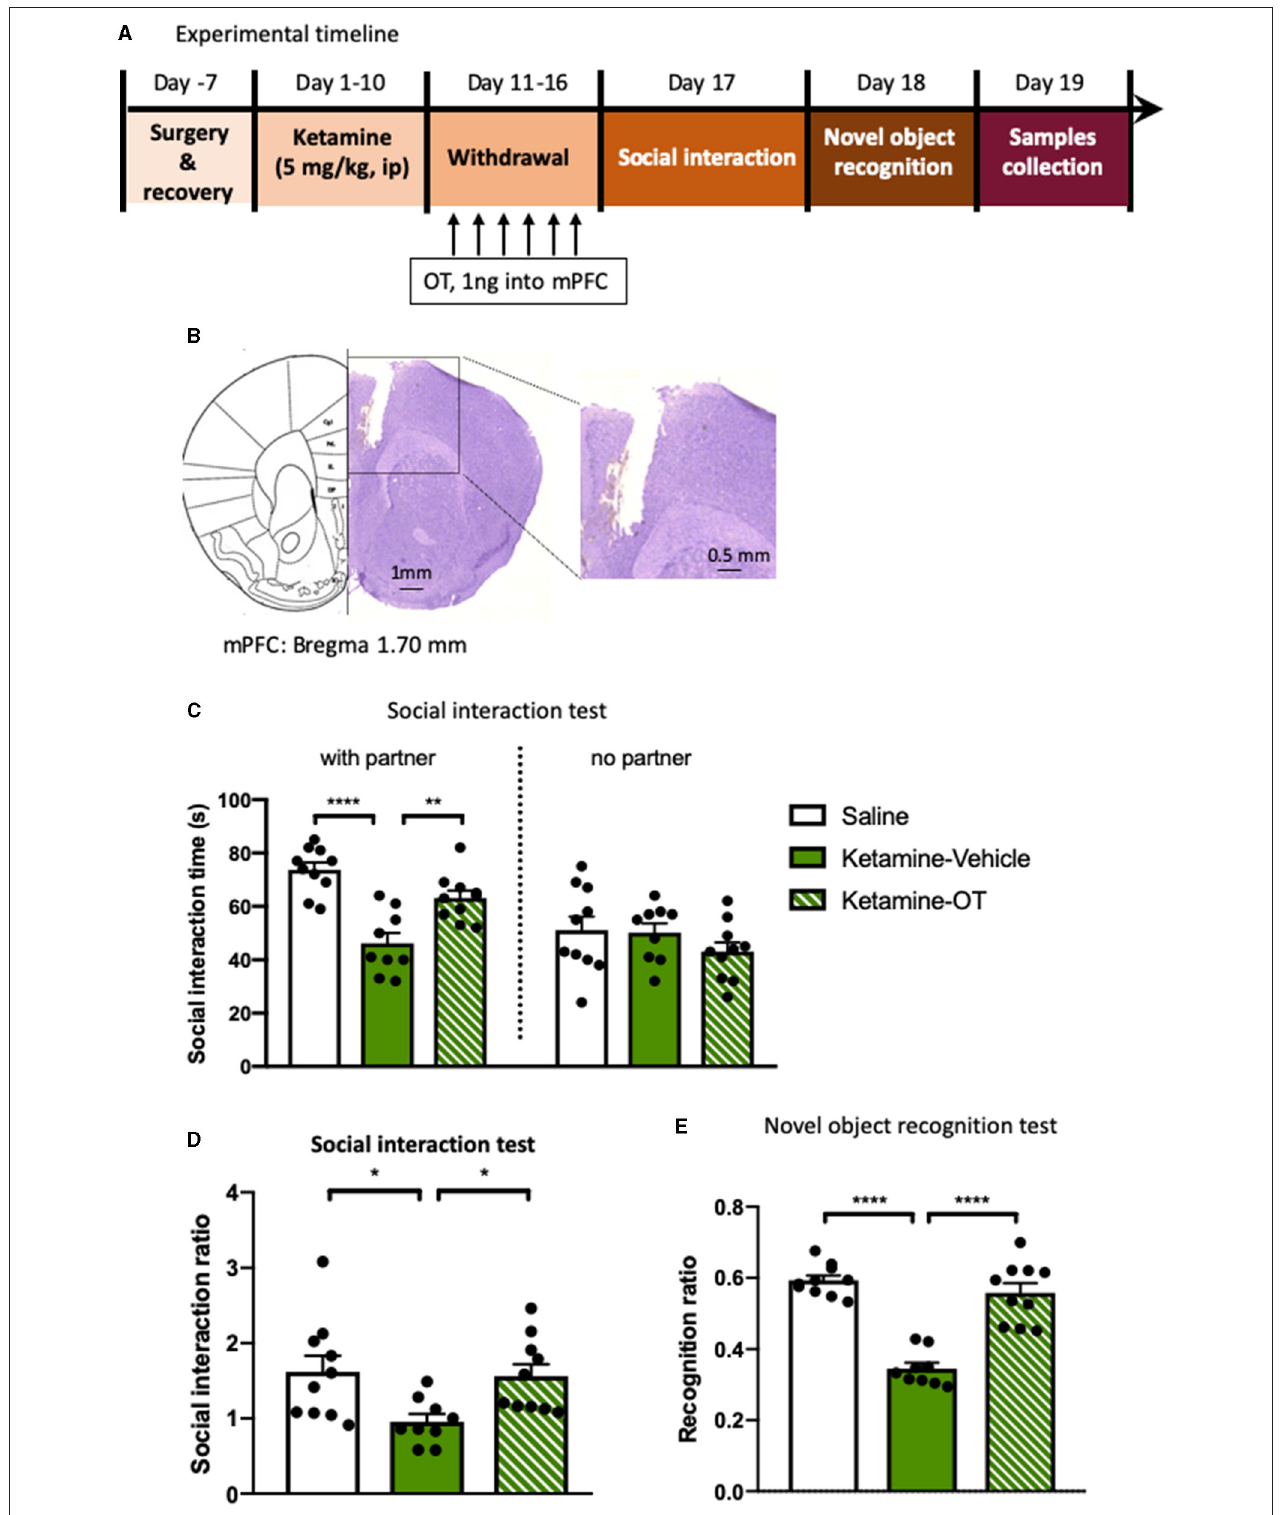
FIGURE 3 | Microinjection of oxytocin into mPFC reverses the behavioral deficits induced by repeated ketamine administration. (A) Experimental timeline for ketamine treatment, oxytocin microinjection, and behavioral protocol. (B) The indicative photograph of the injection sites of coronal brain sections and representative cannula placements in the mPFC. (C) The time spent in the social interaction zone and (D) the social interaction ratio measured in social interaction test. (E) The recognition ratio measured in the novel object recognition test. Data are presented as mean ± SEM. * p < 0.05, ** p < 0.01, **** p < 0.0001 compared with saline or ketamine-vehicle group. n = 9–10 per group. OT,